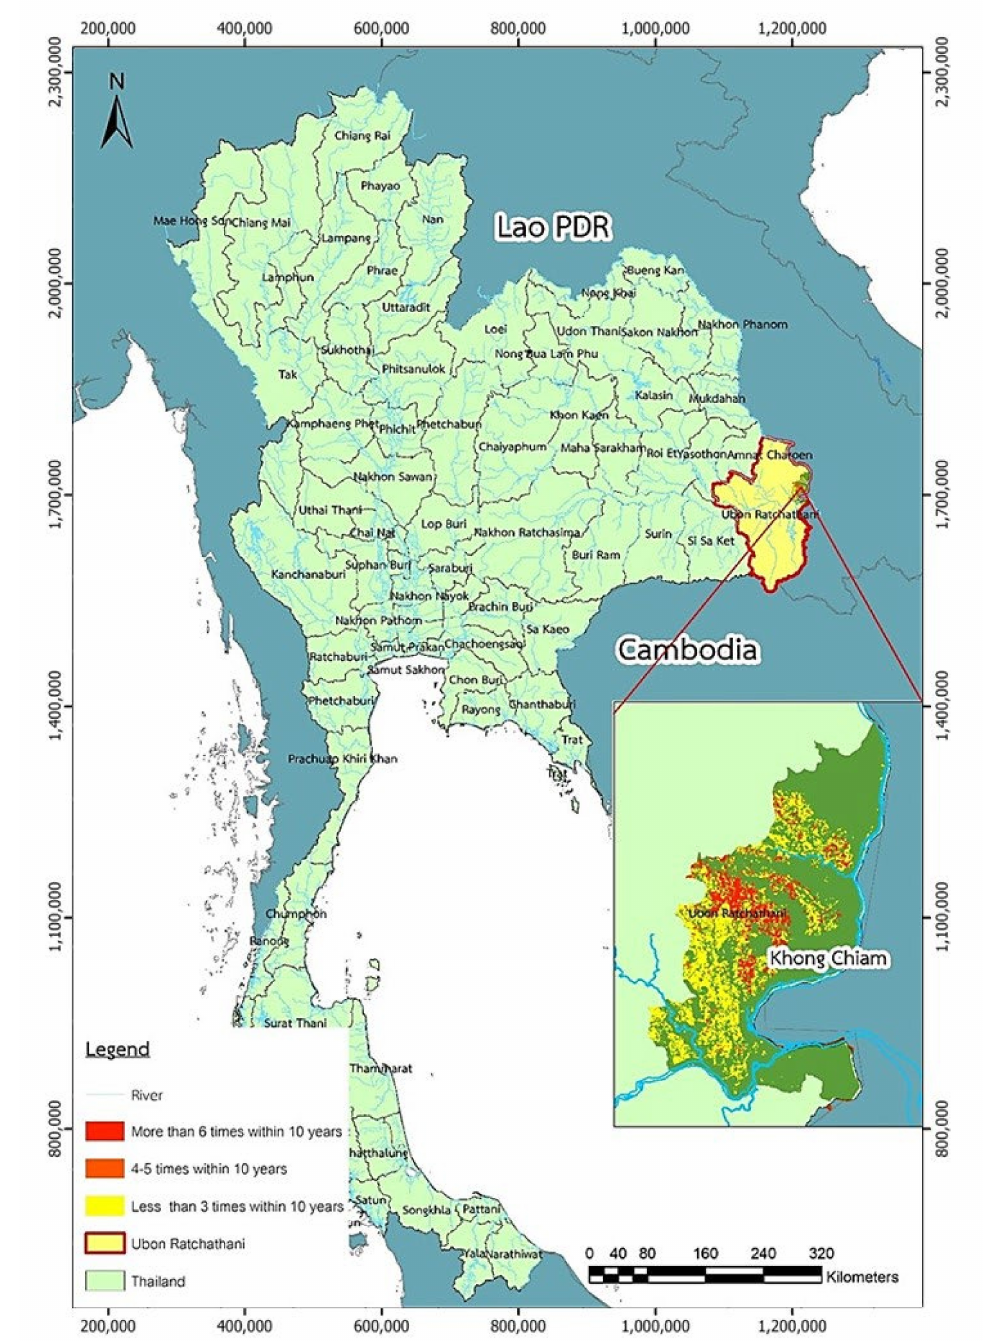
Figure 1. Map of Thailand showing the study